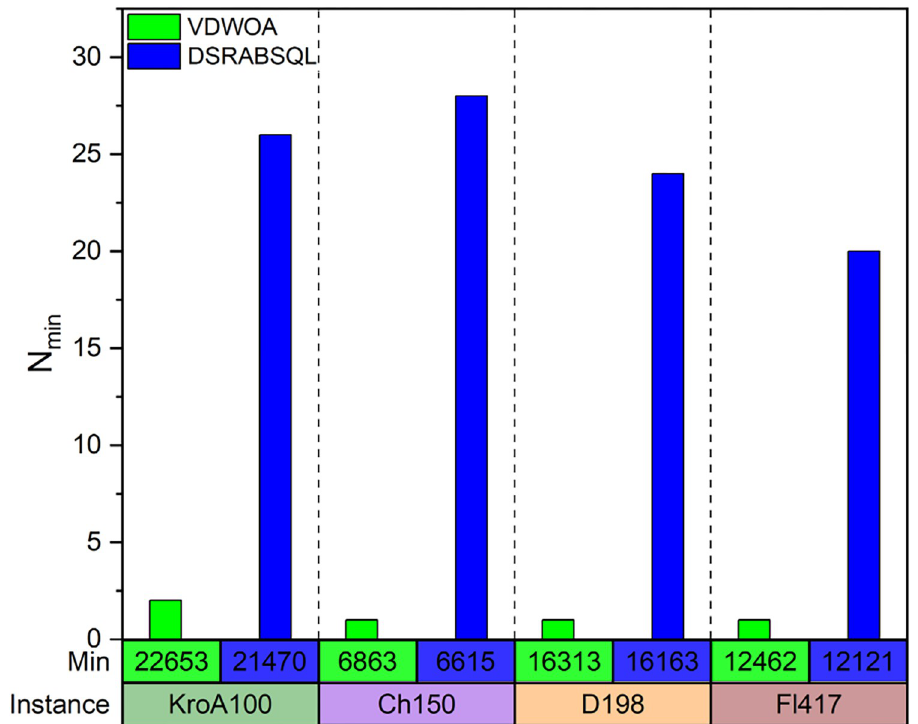
Fig 11. The N of DSRABSQL and VDWOA algorithms obtained by testing kroa100, ch150, d198, fl417 50 min times, respectively.